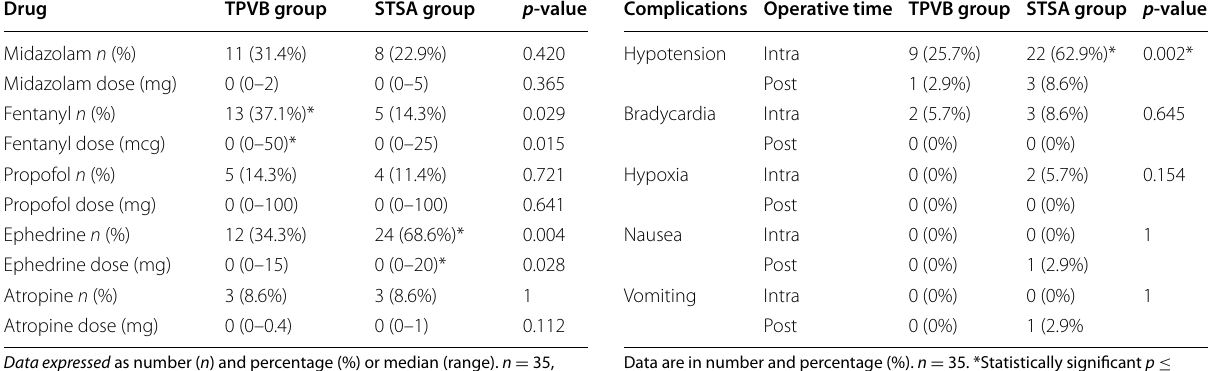
Table 6 Intraoperative sedation data of the two groups